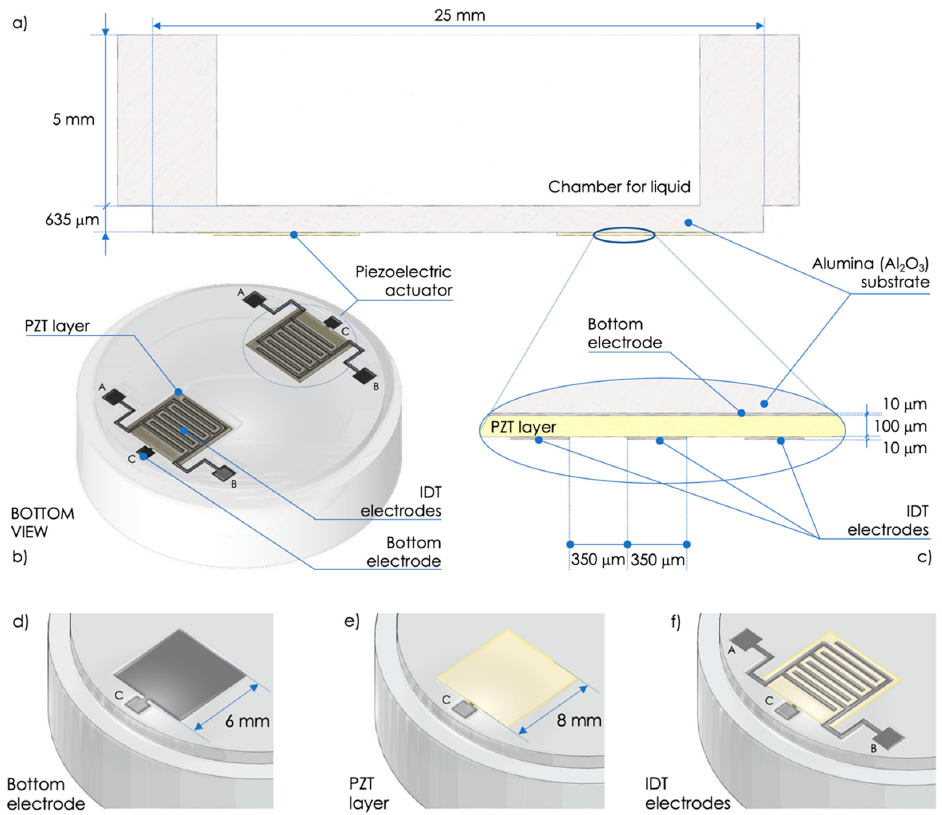
Figure 2. Section ( a ) and bottom view ( b ) of the device. Enlarged view of a cross-section of the piezoelectric actuator ( c ). Fabrication process: deposition of the bottom electrode ( d ), lead zirconate titanate (PZT) layer ( e ), and interdigital transducer (IDT) electrodes ( f ).